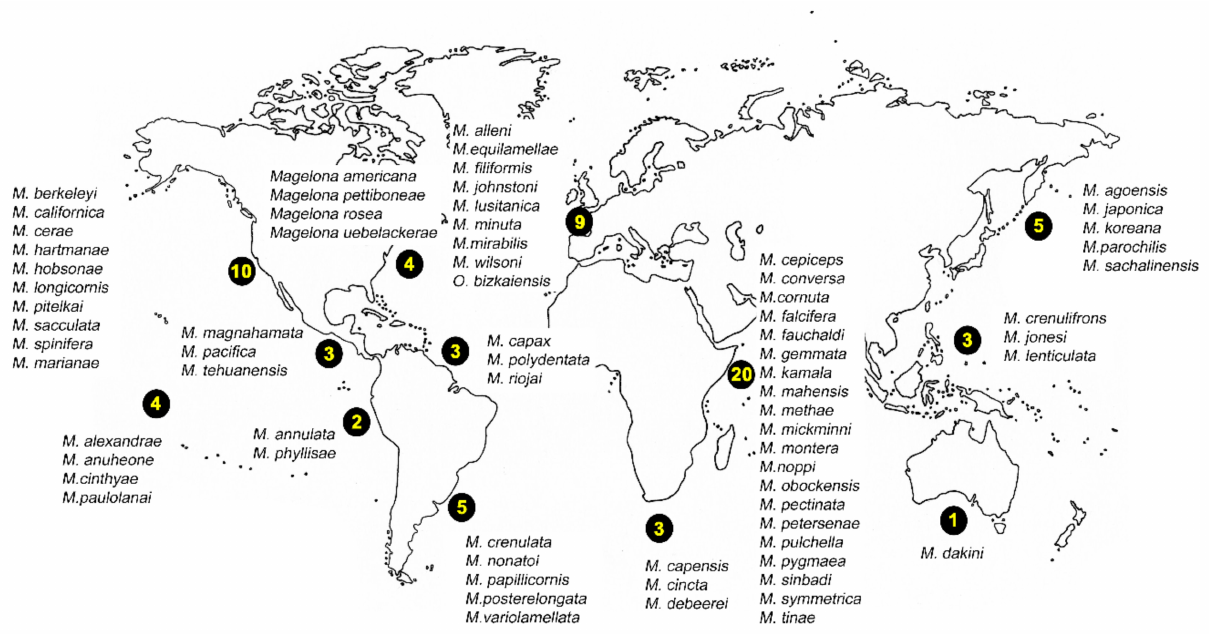
Figure 8. World map showing number of magelonid species described per realms (sensu